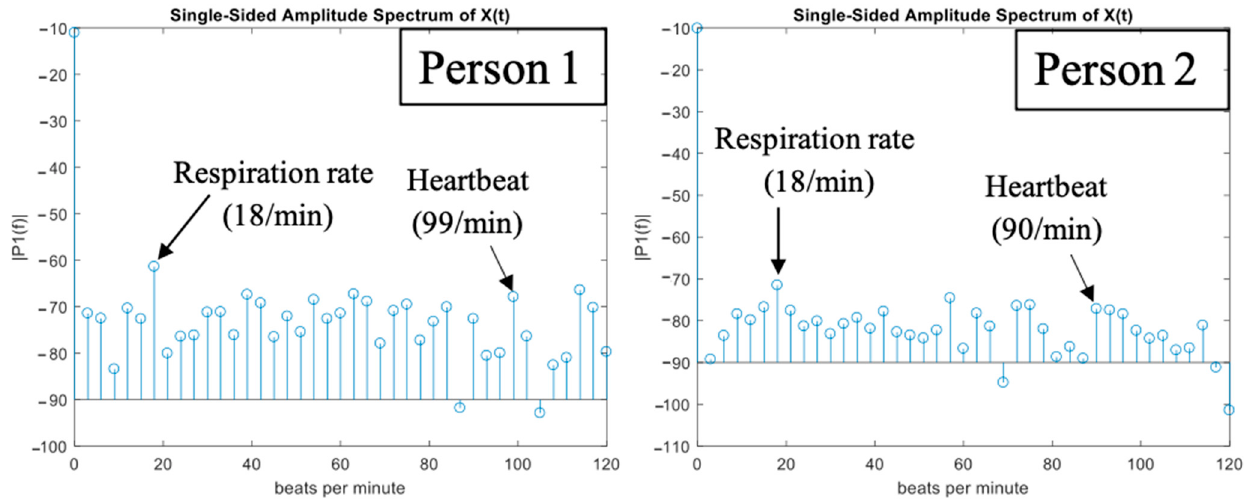
Figure 27. The measured respiration and heartbeat rates of two targets [52].